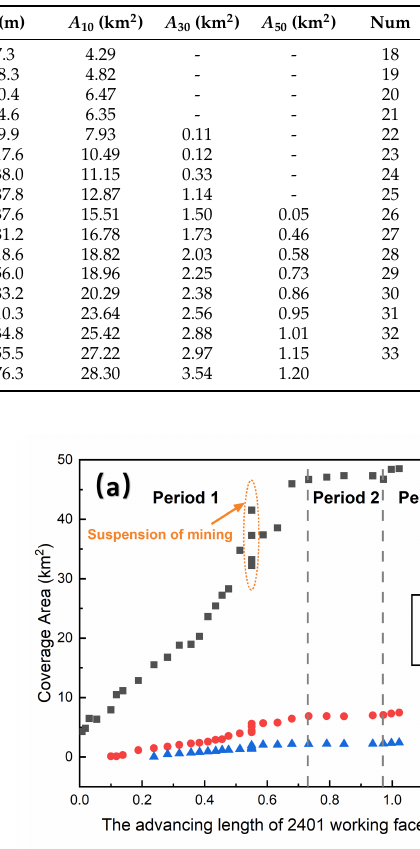
Table 4. Coverage area of subsidence value over 10, 20 and 50 mm with different advance lengths of 2401 working face.